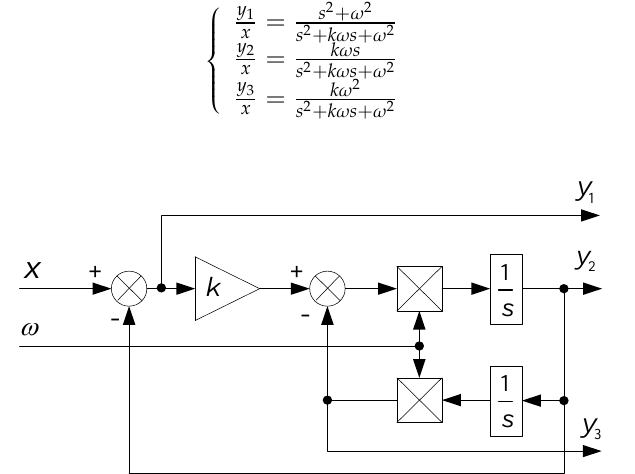
Figure 5. Basic structure of the second-order generalized integrator (SOGI).